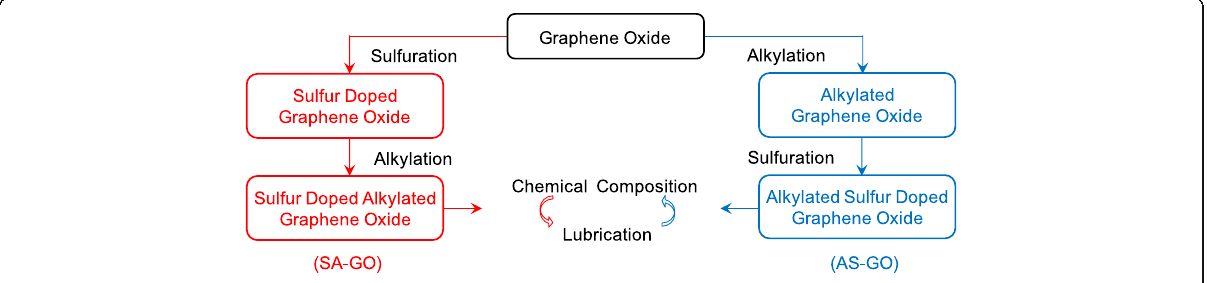
Fig. 11 The contrastive research routes of SA-GO and